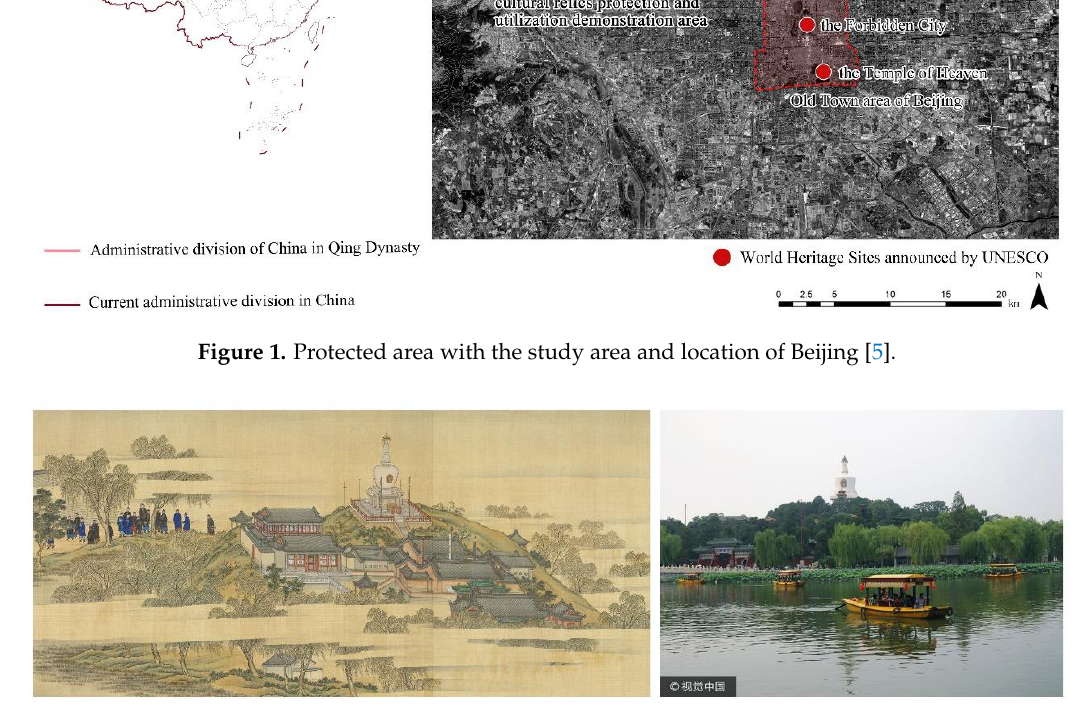
Figure 2. Historical changes of Beihai (a royal garden), see the left for the “Qincan” ceremony held in Beihai in the Qing Dynasty (silkworm breeding in Qing Dynasty, collected from the Taipei Palace Museum) [6], and the right for the Beihai Park photo in Beijing now [7].